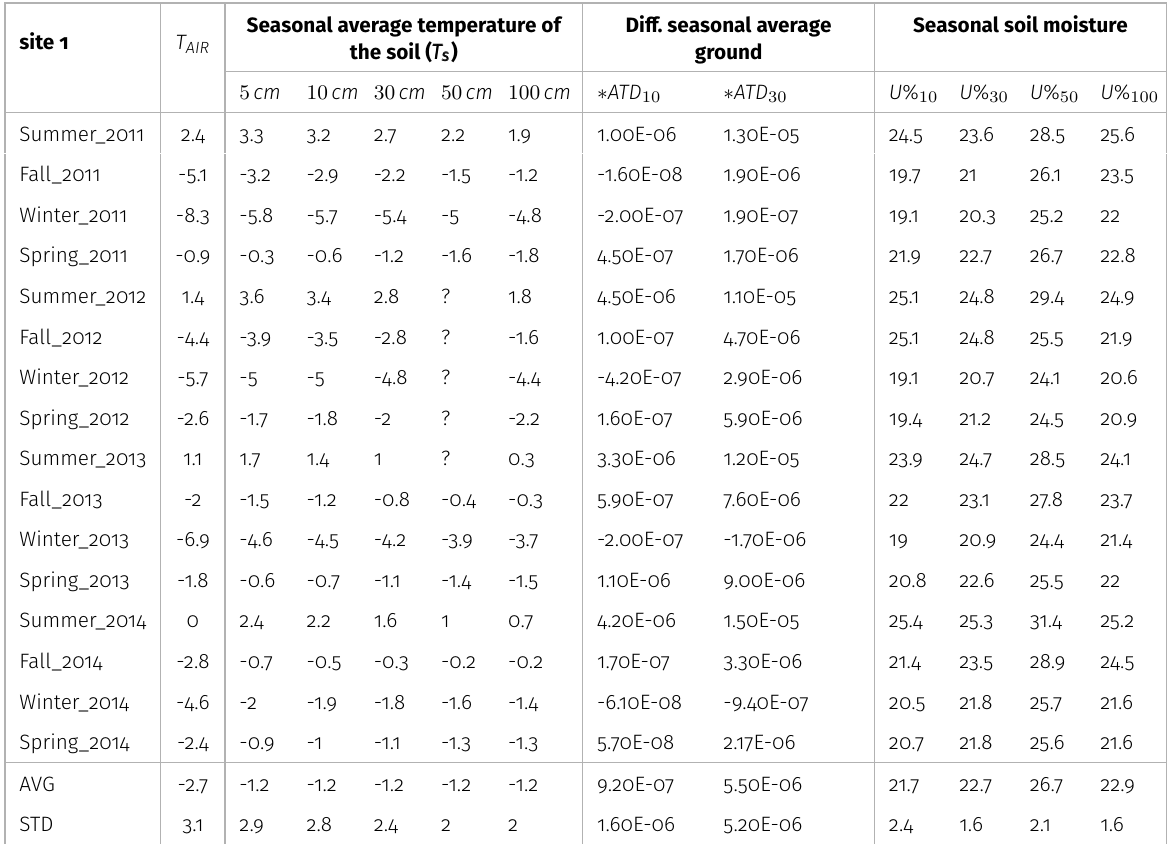
Table III. Seasonal averages of air temperature ( T AIR T AIR T AIR ) and soil ( T s T s T s ) at five depths; Seasonal thermal diffusivity ( ATD 1 0 ATD 1 0 ATD 1 0